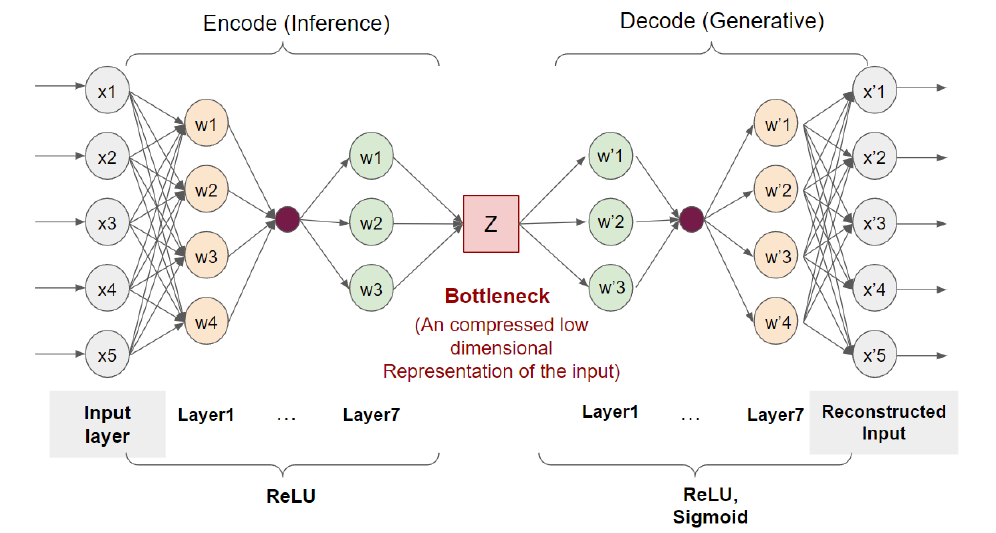
Figure 5. A structure of the autoencoder used in our